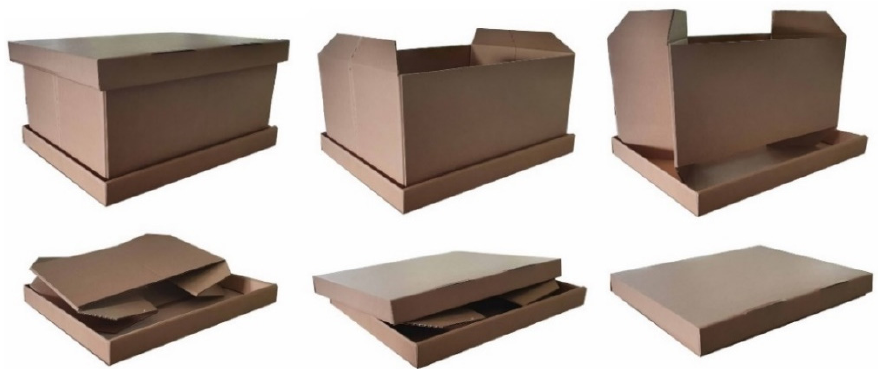
Figure 14. Folding principle of the developed tripartite cardboard package.